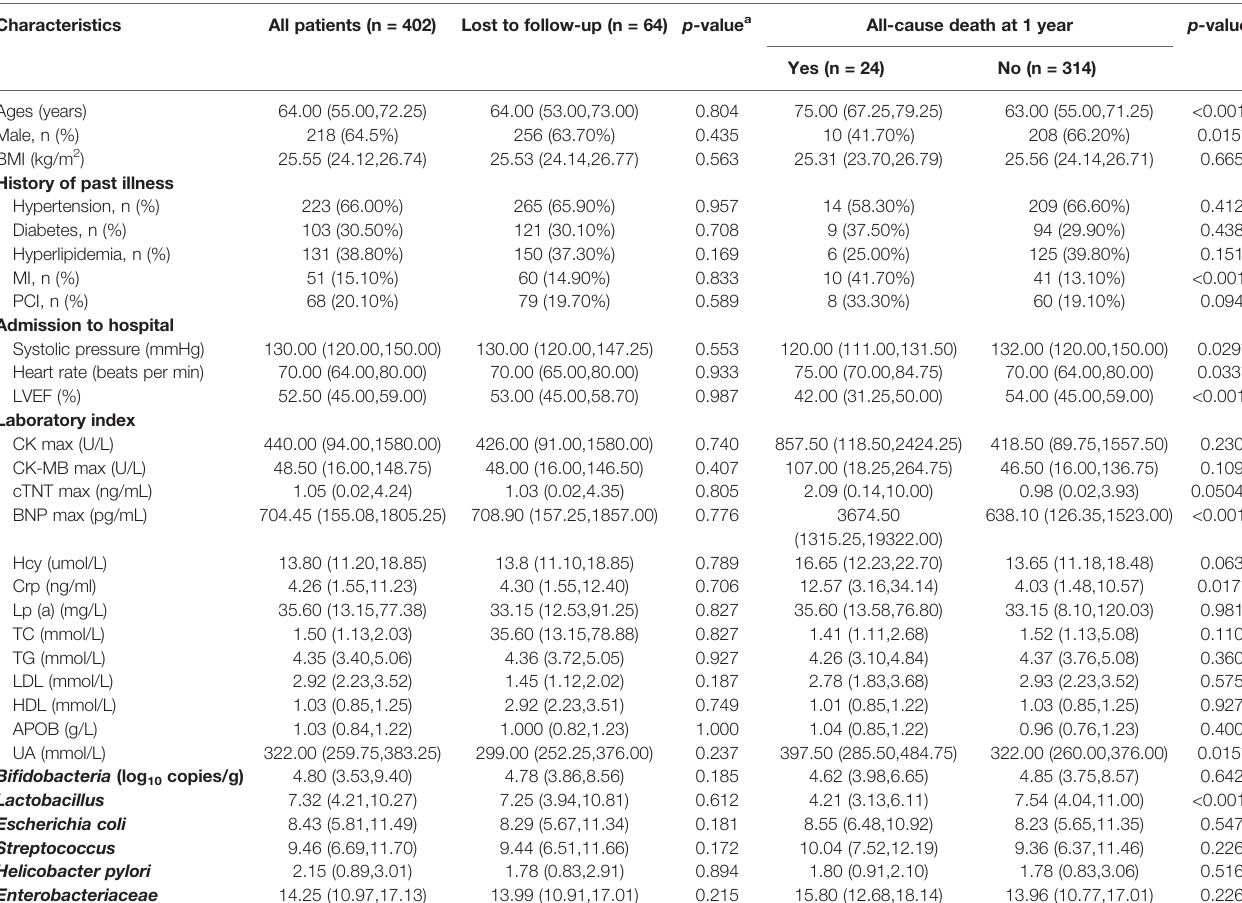
TABLE 3 | Baseline data for all-cause death analysis .